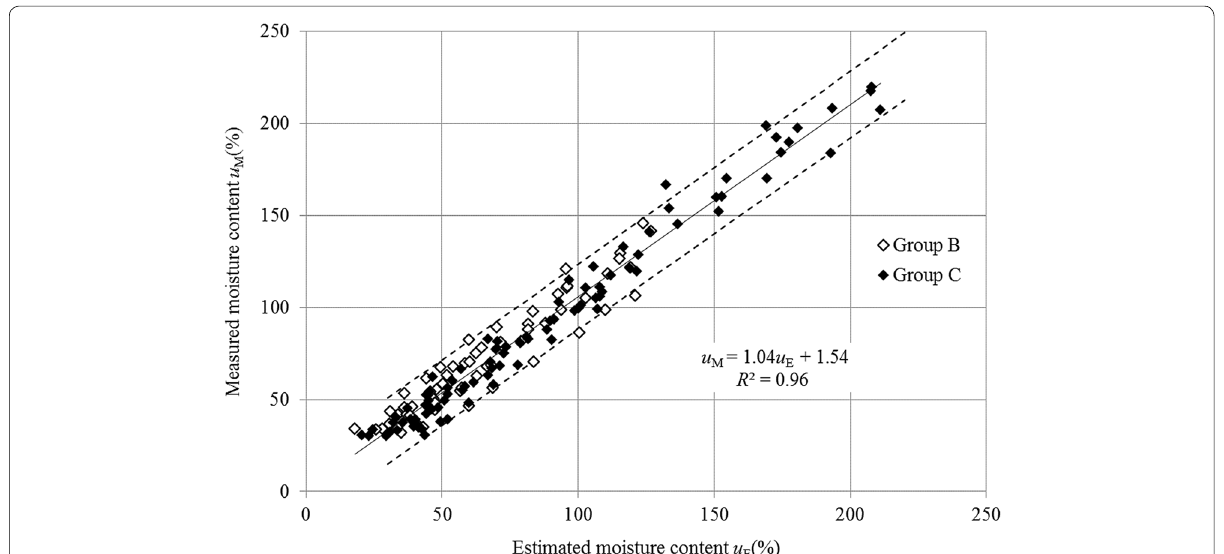
Fig. 5 Relationship between the estimated moisture content u E and measured moisture content u M . The solid line represents the best-fit to the data, and the two broken lines are the prediction